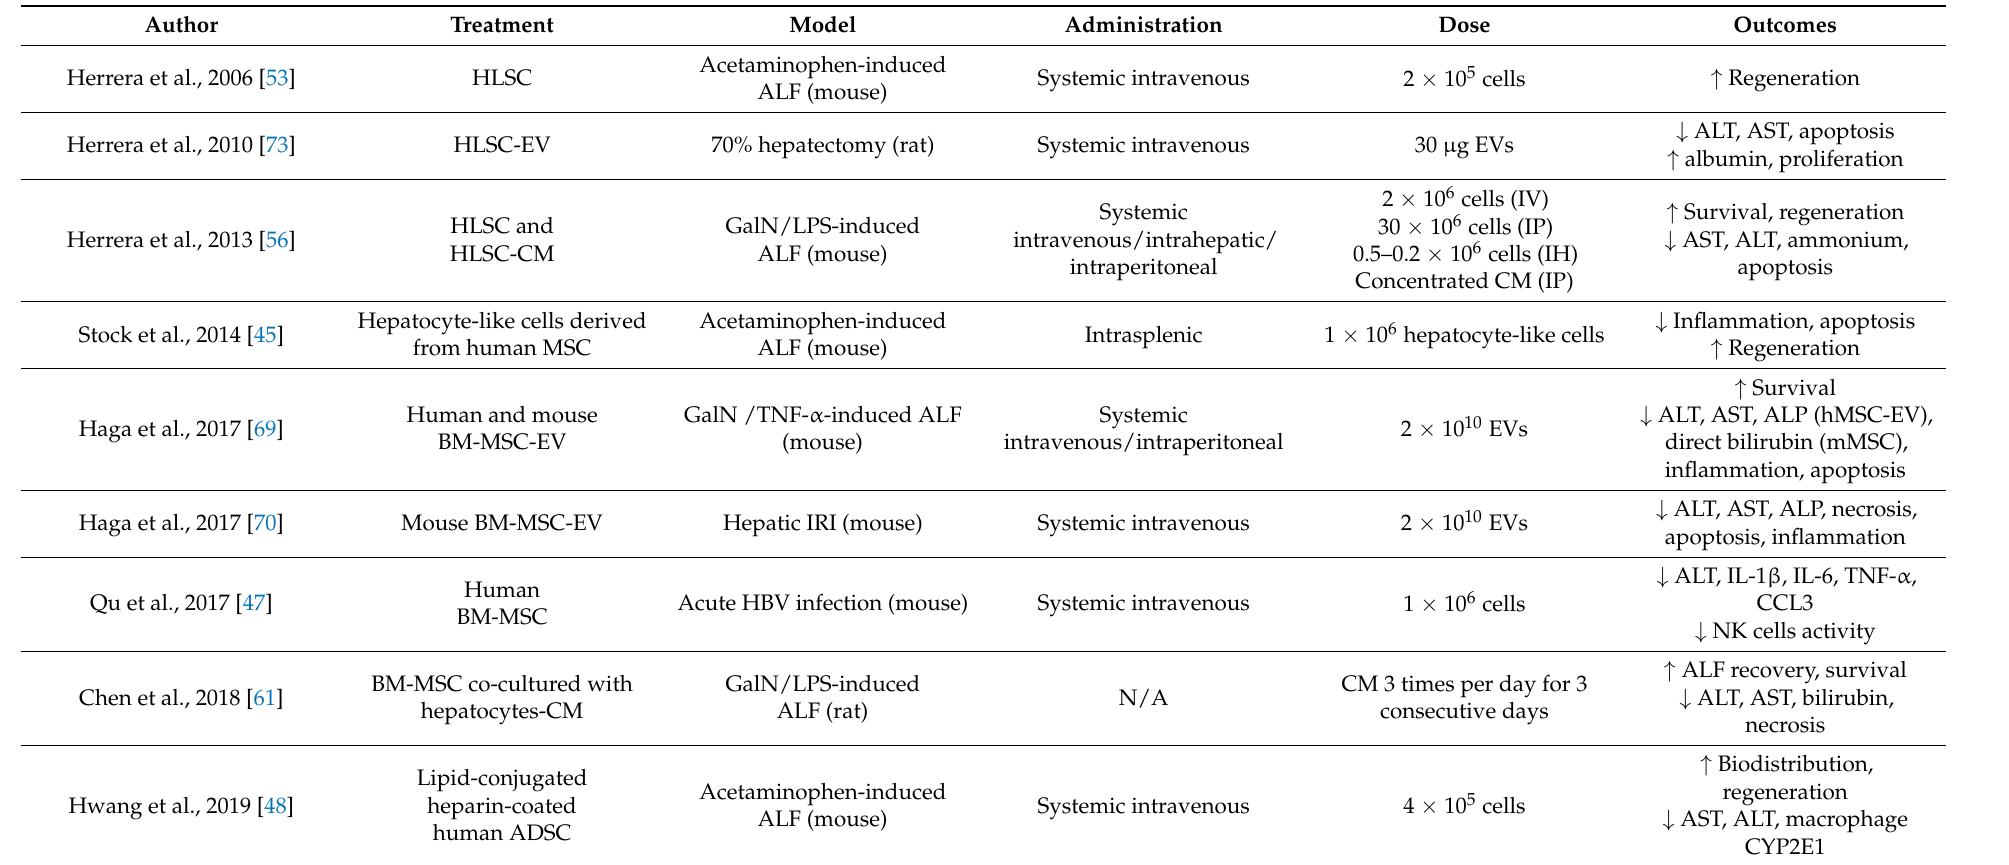
Table 2. Schematic overview of experimental studies applying MSCs and MSC-derived products to treat acute and/or chronic liver